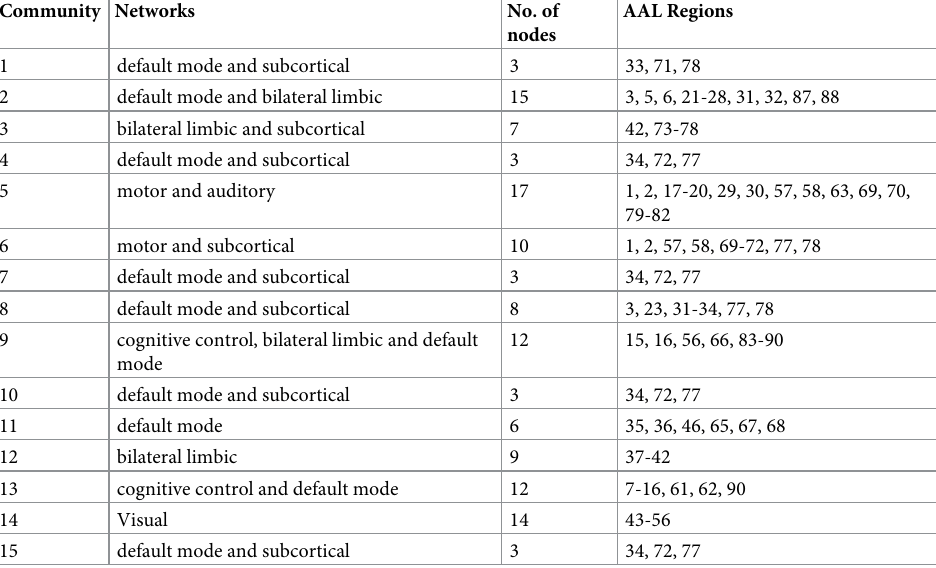
Table 2. Brain networks identified using LR-MVRC with K = 15 in NMF. Fourth column represent AAL atlas ROI indices belonging to the community K , whereas second and third columns represent their corresponding associated brain networks and number of ROIs in one community,